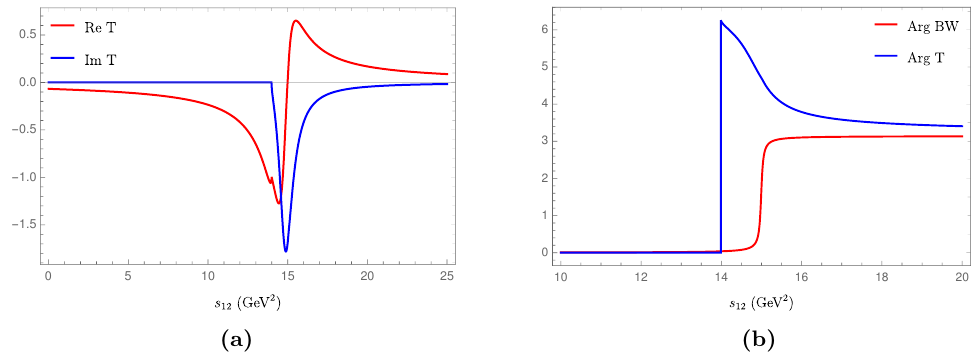
Figure 2. Illustrations of the behavior of the threshold function T R (a) shows the real and imaginary parts of the modi(cid:12)ed propagator T R below and above the open-charm threshold. When the imaginary part is generated, the real part of T R acquires a cusp shown by the kink. (b) Crucial for CP violation is the di(cid:11)erence between the strong phases of T R (blue) and a standard Breit- Wigner shape